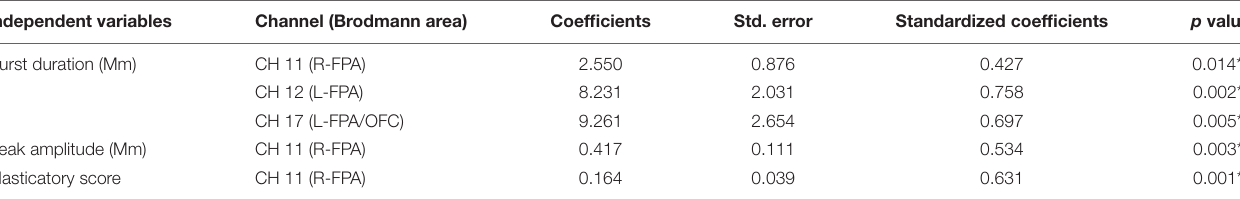
TABLE 6 | Multiple linear regression for association of prefrontal oxygenated hemoglobin concentration [(oxy-Hb)] with masticatory score, burst duration [masseter (Mm)], and peak amplitude (Mm). Independent variables